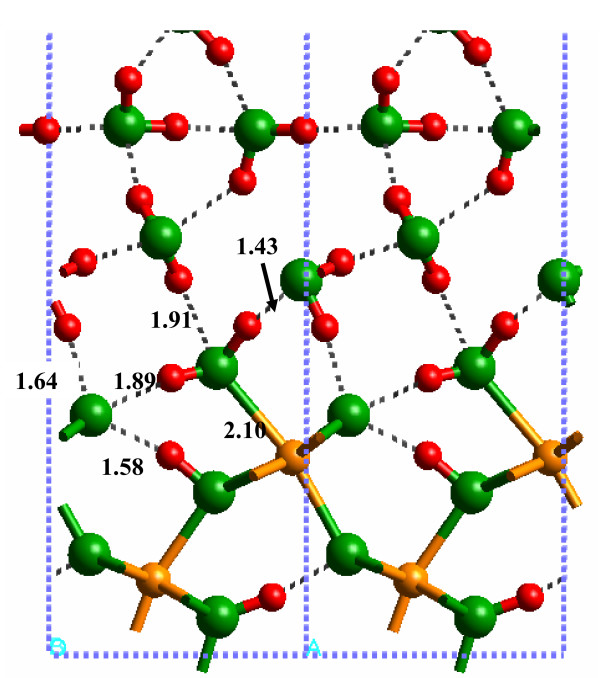
Solvated (010) α-FeOOH surface initial configuration of Fe3OH + Fe2O + FeOH2 with SP-GGA+U.